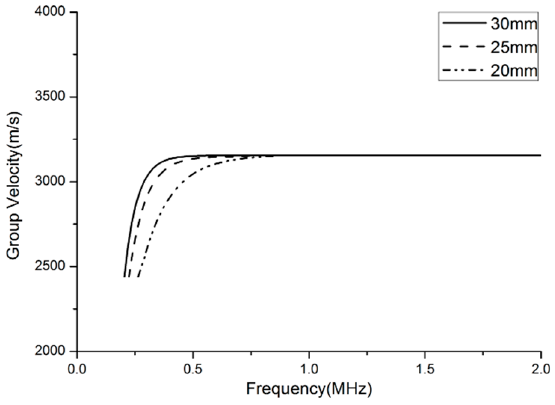
Figure 5. Group velocity dispersion curves against frequency.